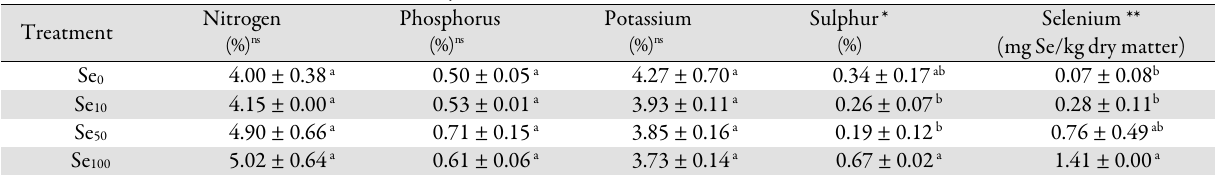
Table 5. Nutrient elements of broccoli as affected by Se treatments Treatment